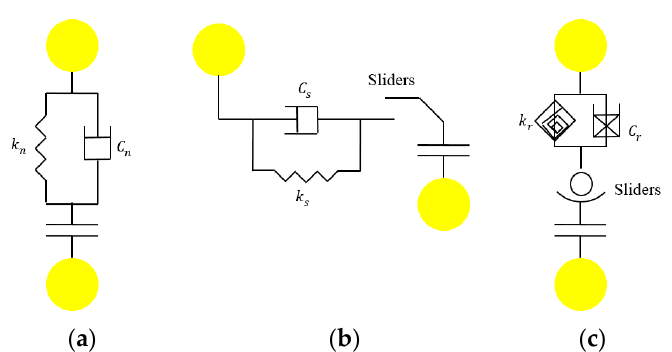
Figure 2. Schematic diagram of the anti-rolling linear contact model: ( a ) Normal contact part, ( b ) Tangential contact part, ( c ) Anti-rolling contact part. (Adapted with permission from Ref. [33]. 2014, Song, Y.; Yang, L.; Zhao, J).